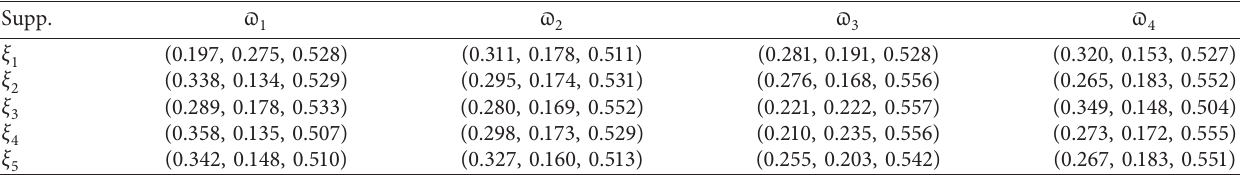
Table 27: Aggregated weighted intuitionistic fuzzy decision matrix.